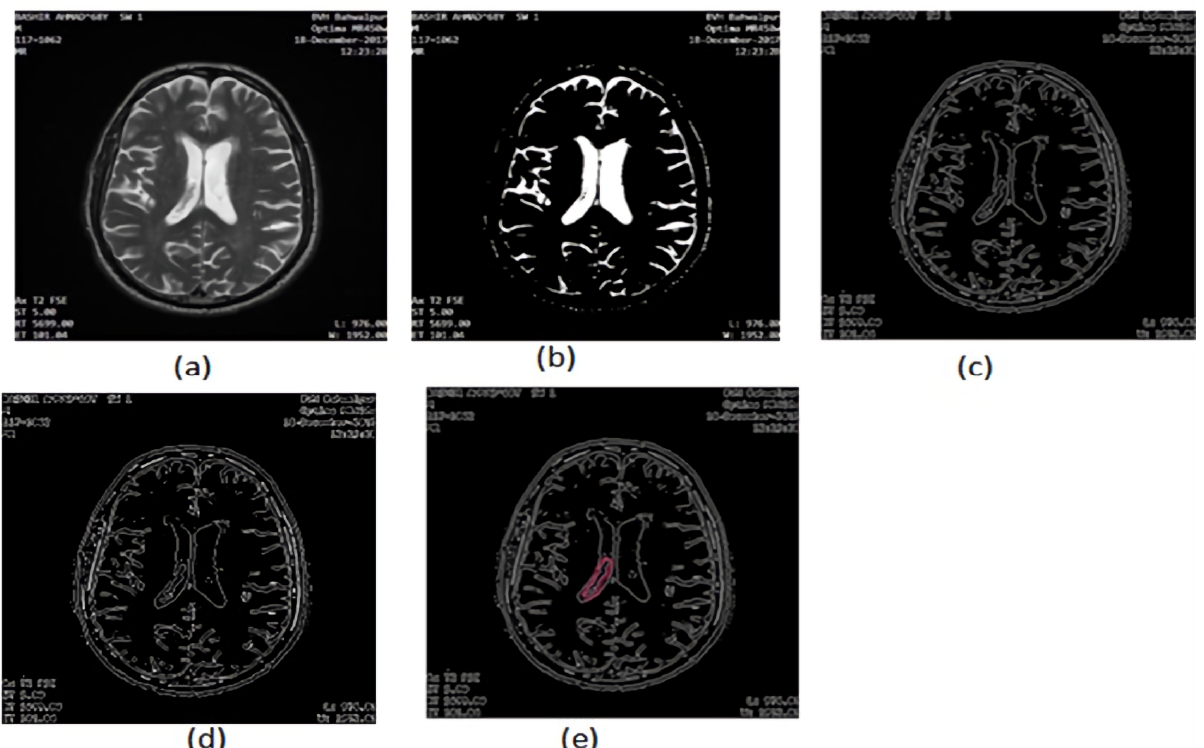
Figure 6. Processing and results of BVH dataset. ( a ) Grayscale image; ( b ) segmentation; ( c ) morpho- logical operations; ( d ) ROI selection and coloring; ( e ) differentiated tissue.